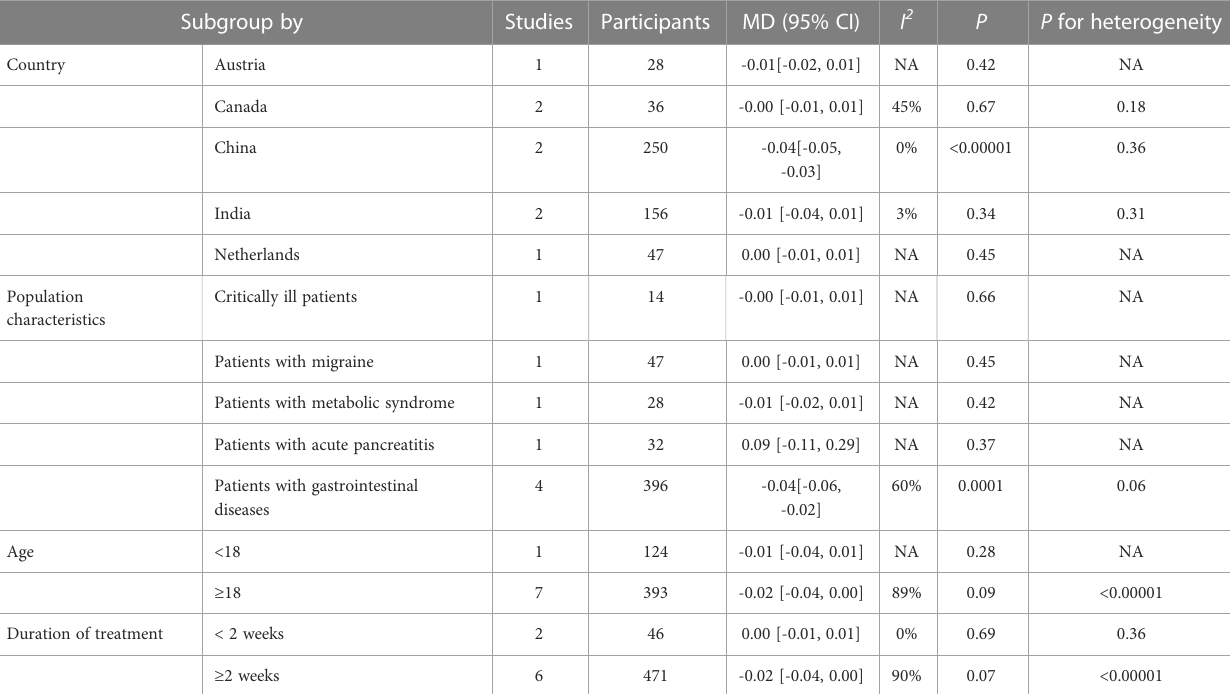
TABLE 5 Subgroup analysis of L/M.